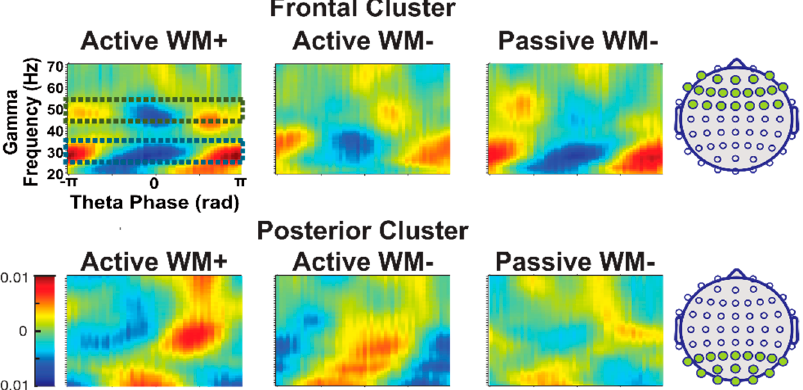
Figure 3. Average normalized gamma amplitude at each theta phase across our two clusters of interest, averaged across all 60 subjects of the primary